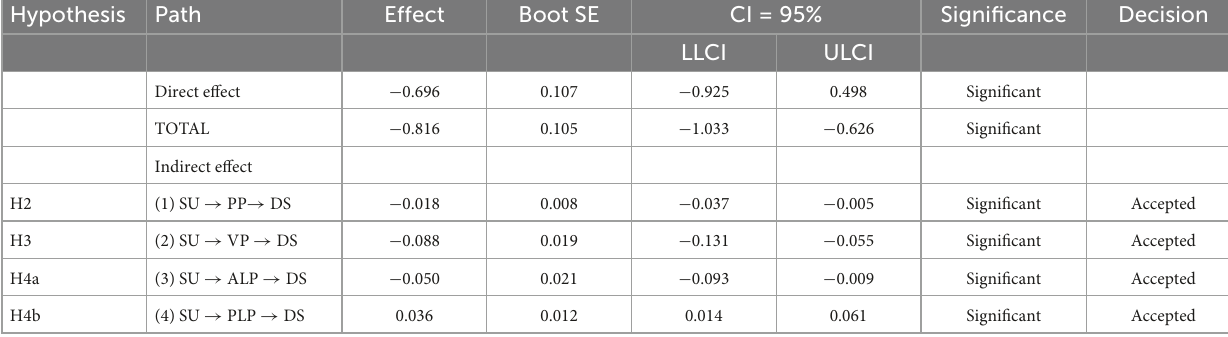
TABLE 4 Estimation results of mediating